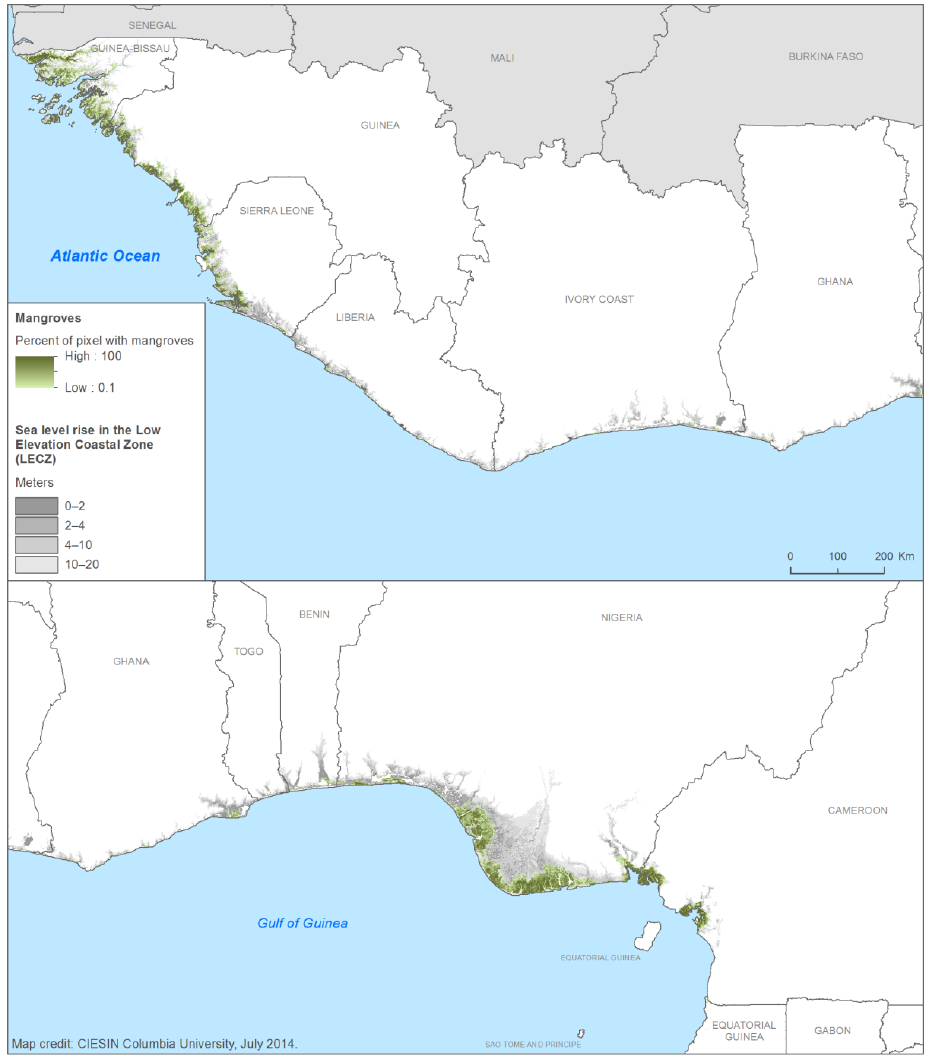
Figure 8. Mangroves and the